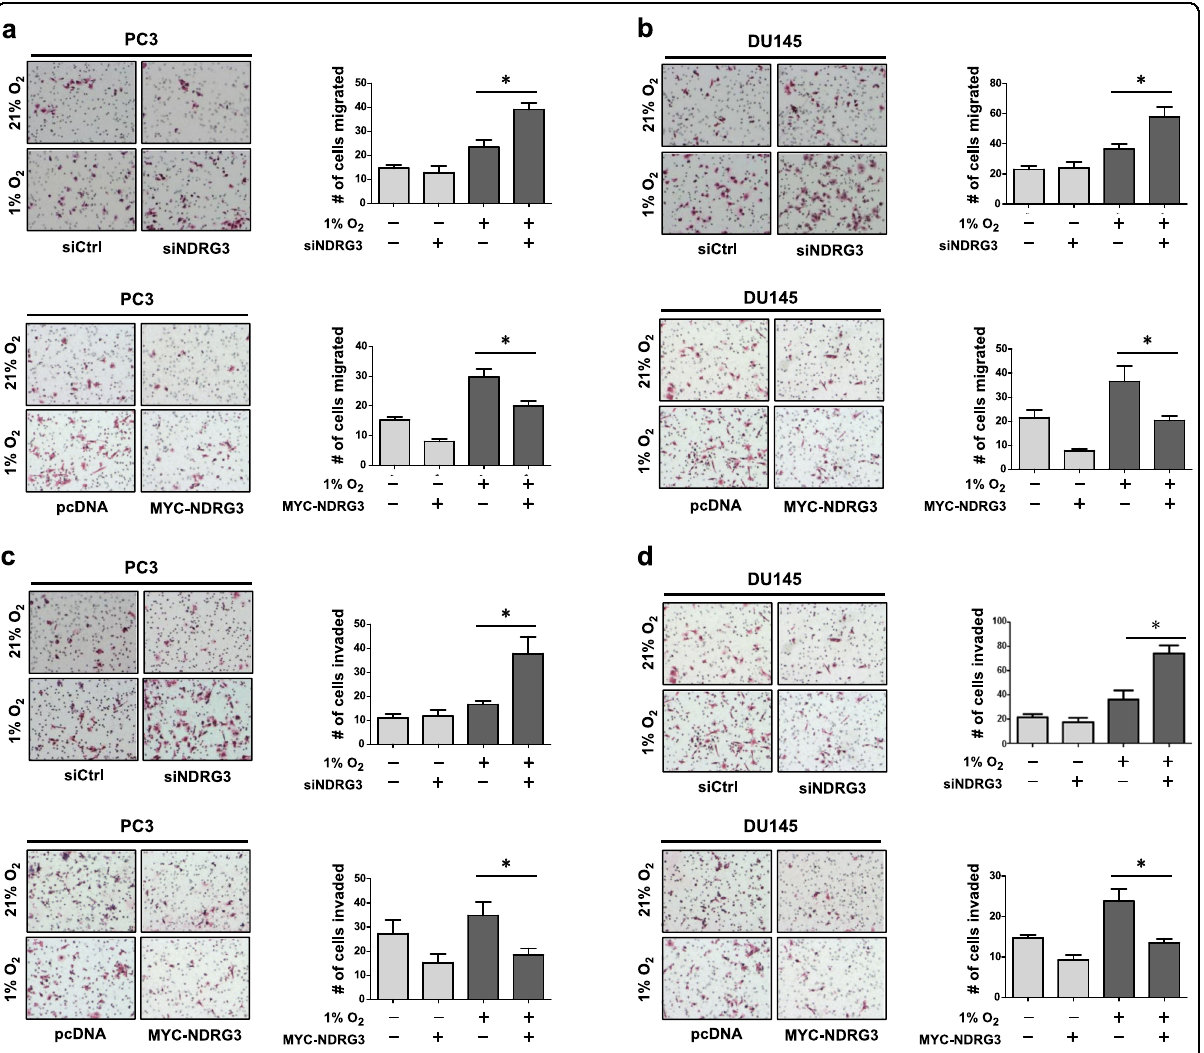
Fig. 6 NDRG3 inhibits the migration and invasion of prostate cancer cells. PC3 ( a , c ) or DU145 ( b , d ) cells were transfected with siNDRG3 or MYC-NDRG3, and 1 × 10 4 cells were seeded in a transwell culture plate. The upper chambers were fi lled with serum-free media and the lower chambers with 10% FBS-containing media. Migration and invasion analyses were performed using uncoated and Matrigel-coated interface membranes, respectively. After cells were incubated under normoxia or hypoxia for 24 h, the membranes were fi xed in 4% PFA and subjected to H&E staining. Representative images of each group are shown on the left, and the numbers (means + s.d., n = 3) of migrated or invaded cells are shown as bar graphs on the right. * denotes P <